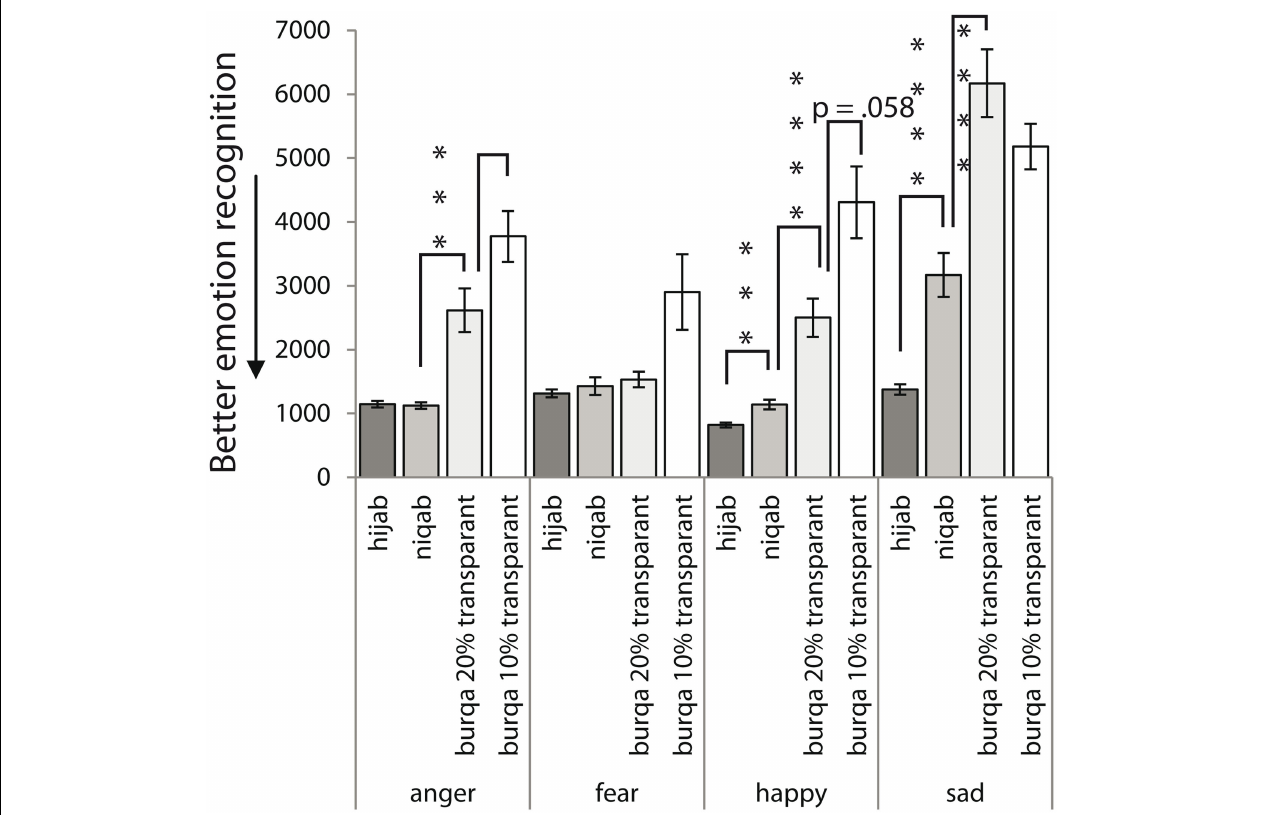
FIGURE 2 | Experiment 1. Inverse efficiency scores for the recognition of facial expressions in an Islamic context. Fearful and angry faces were equally well recognized in the hij ¯ ab as the niq ¯ ab condition. Fear was still recognized